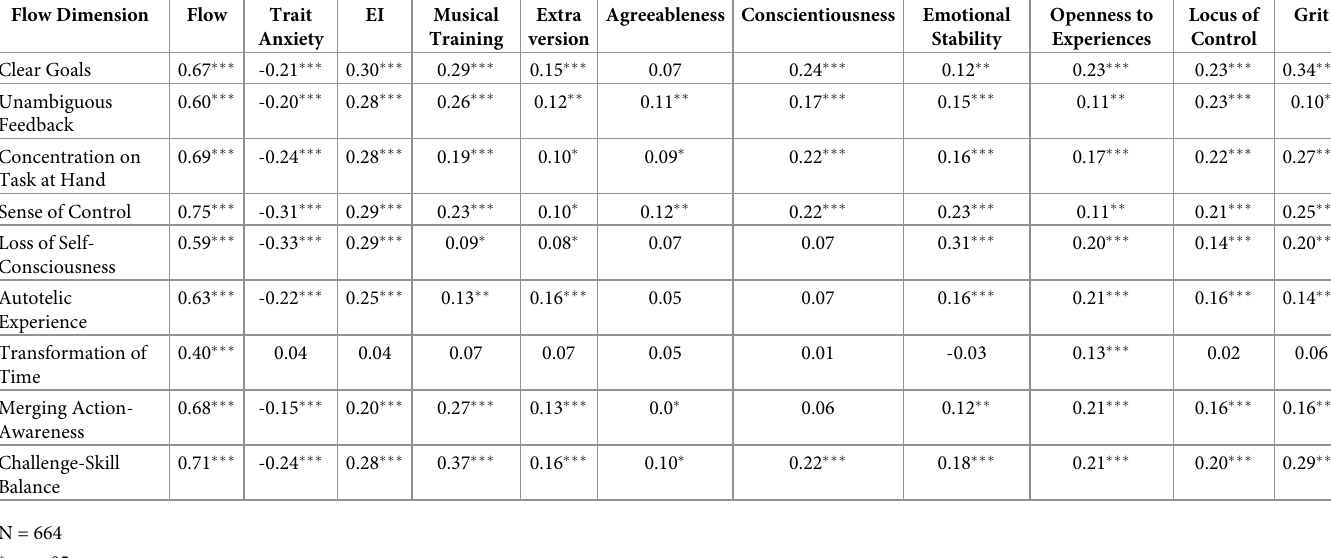
Table 4. Pearson’s r correlations between the 9 flow dimensions and all main variables. Flow